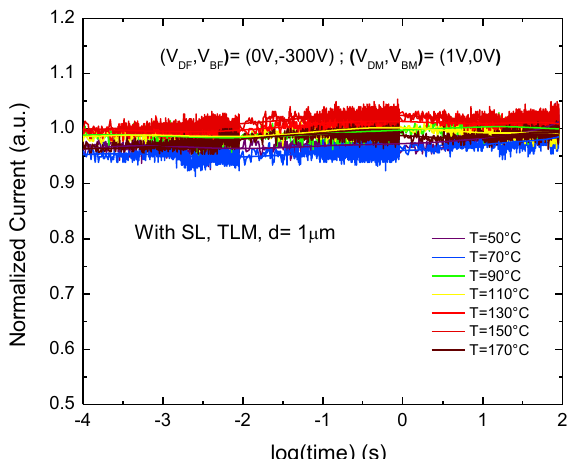
Figure 10. Current transient behavior at multiple temperatures from 50 to 170 °C on a TLM with distance of 1 μm on the sample with SL.